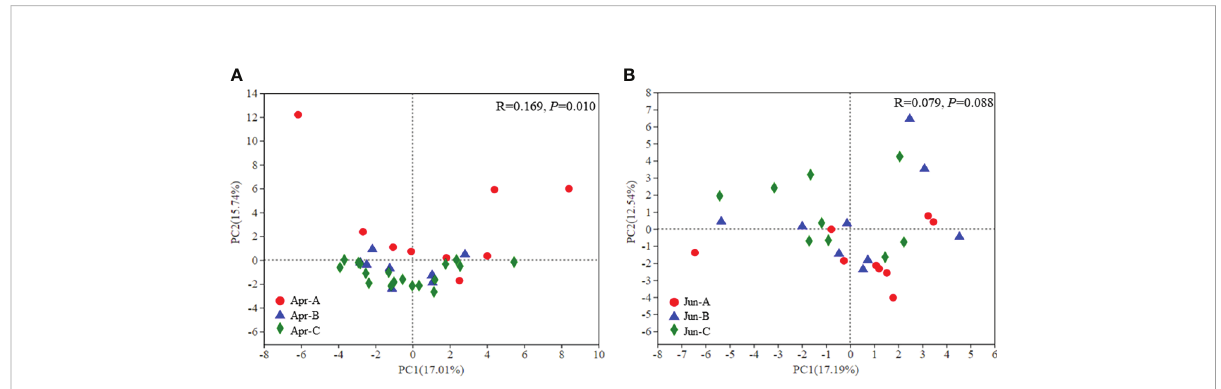
FIGURE 5 b -diversity of phytoplankton community composition in April (A) and June (B) based on PCA